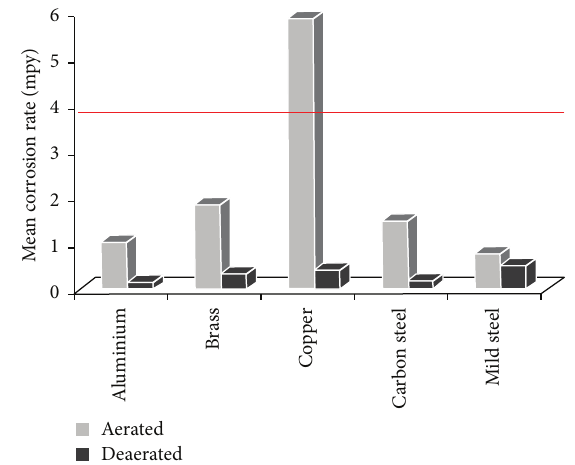
Figure 4: Comparison of mean corrosion rates of studied metals in B100 using rotating